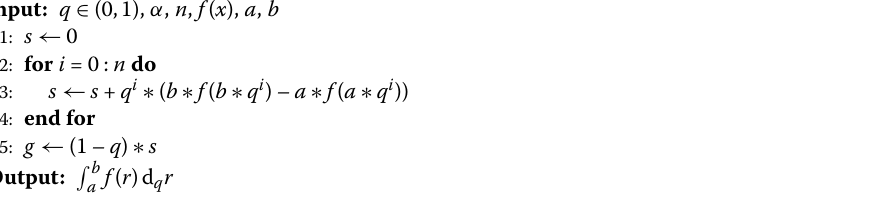
Algorithm 5 The proposed method for calculated